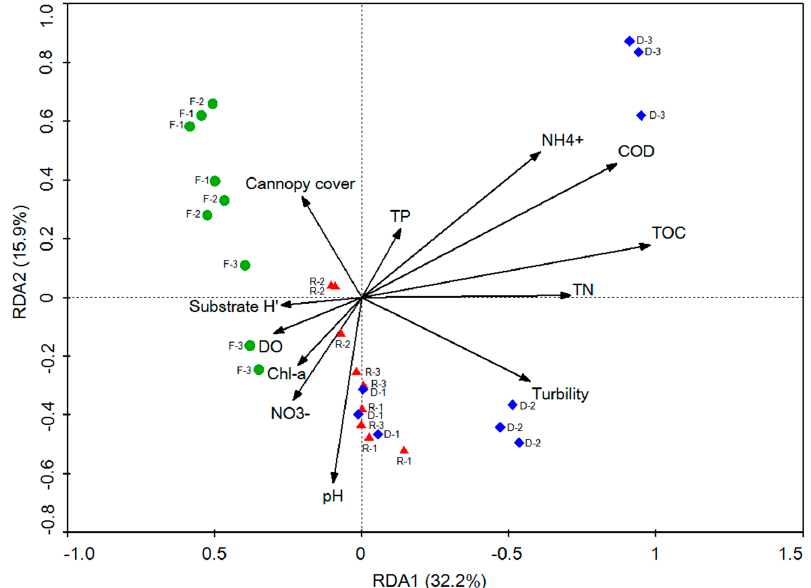
Figure 6. Relationship between the biofilm bacterial community and environmental variables in forested (F, circles), restored (R, triangles) and degraded (D, diamonds) rivers within the Anji City Region, PRC.